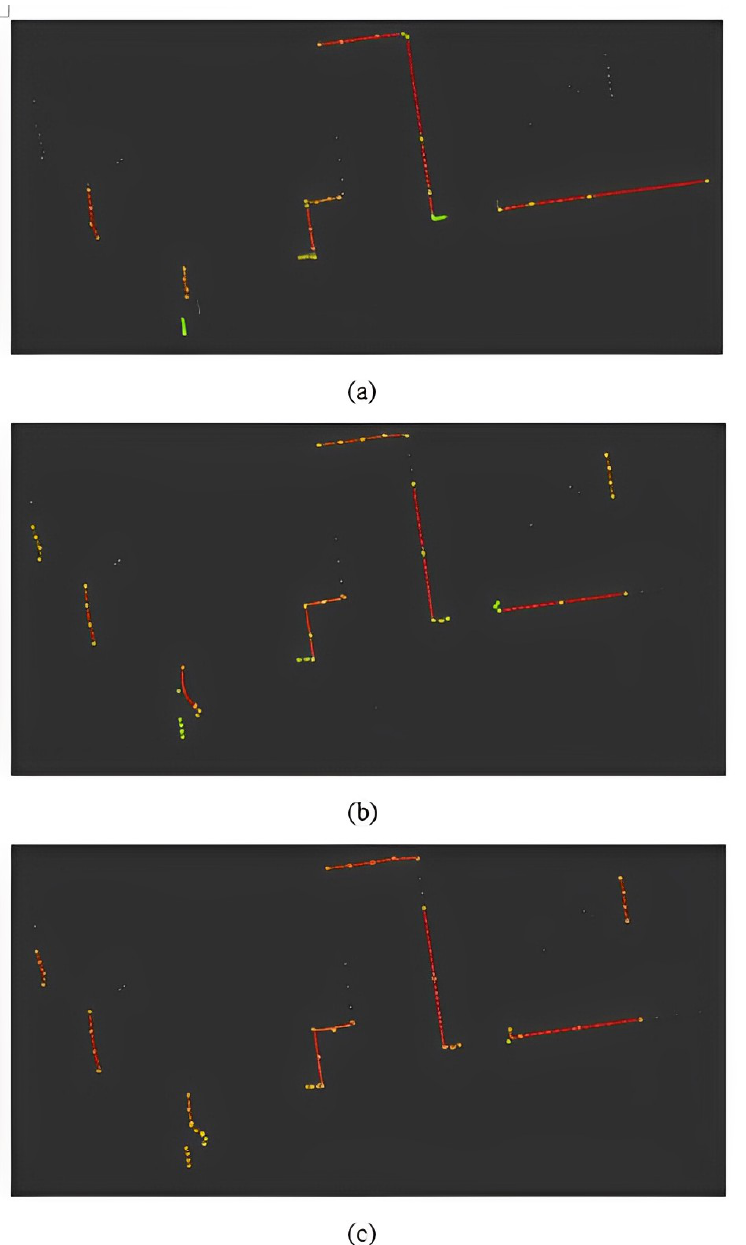
Figure 10. The retrievability and compactness results of ( a ) RPOS-LSBA, ( b ) BID-SVED-PDM, and ( c ) FALKO-SVED-PDM feature extraction approaches. White datapoints show wasted data, and green points are the control points used to represent the B-splines in the